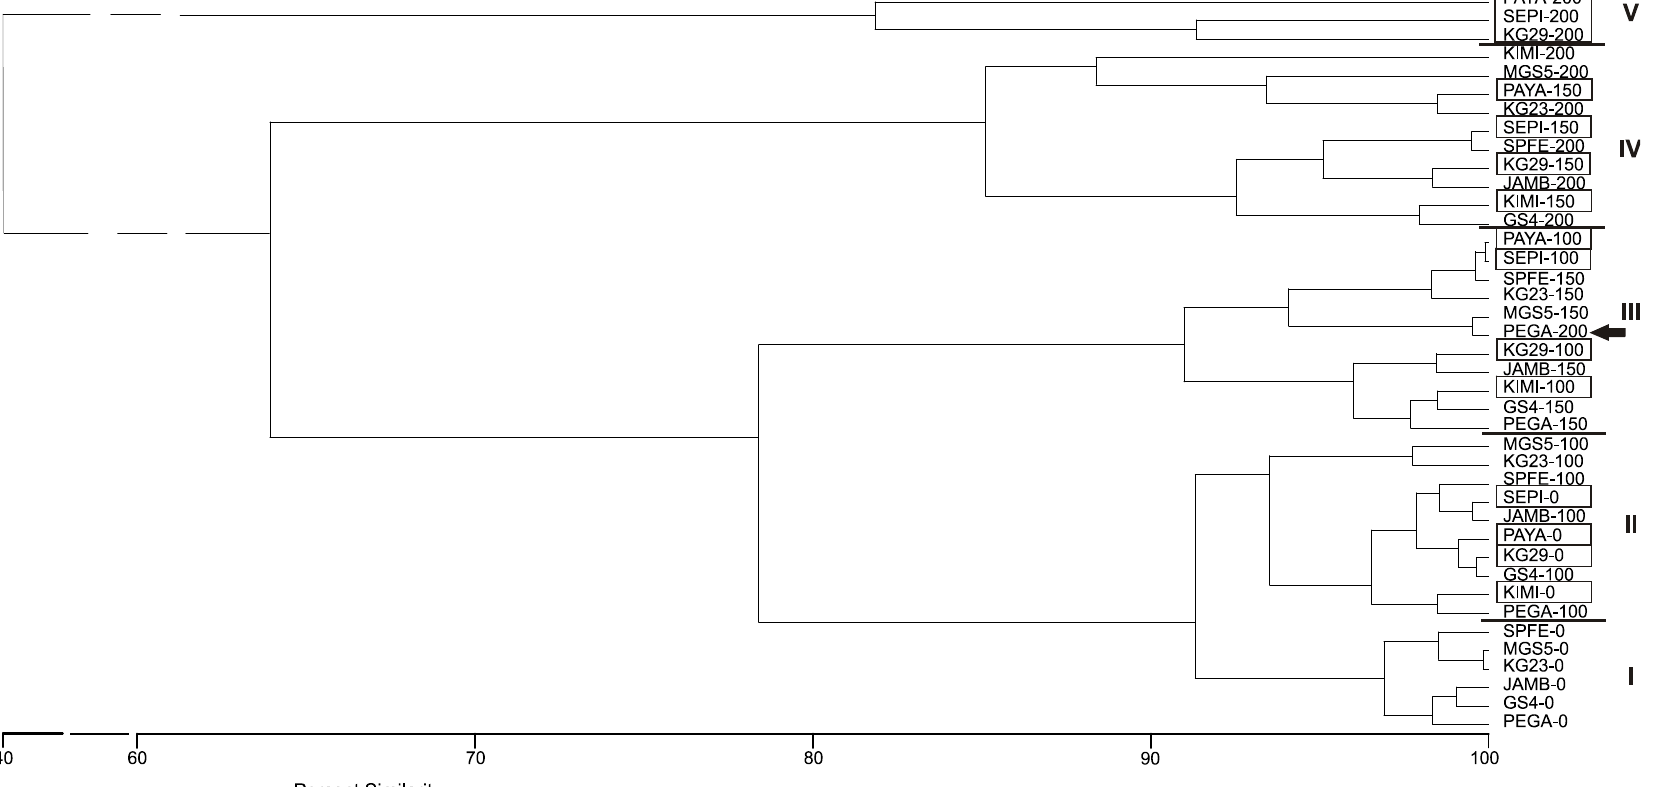
Figure 2. Results of hierarchical agglomerative cluster analysis based on all traits in all four salt treatments. Clusters I–V according to similarity in germination and growth parameters. The most salt sensitive samples in each cluster are in frame. PEGA-0 (genotype abbreviation)–salinity level (mM NaCl).